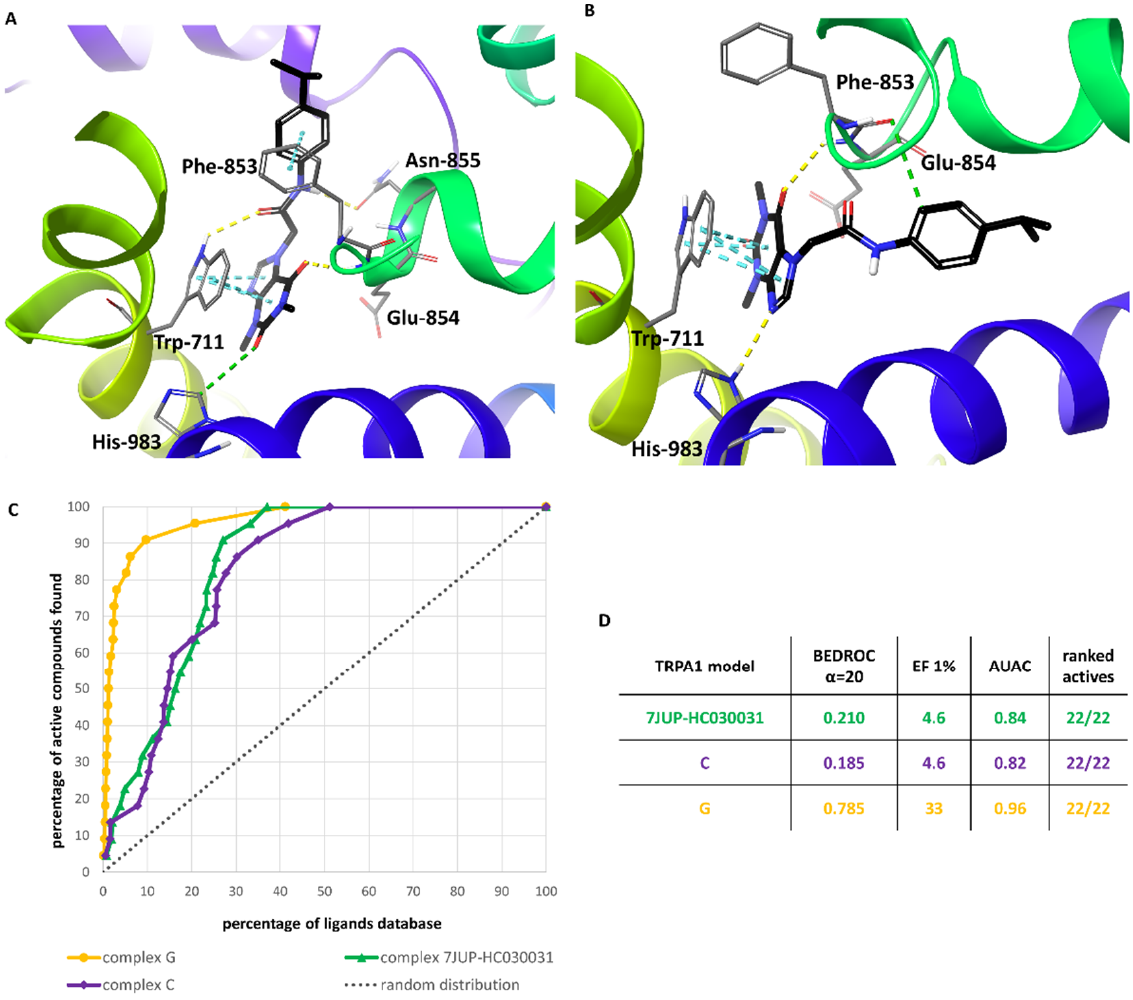
Figure 9. Binding modes of HC-030031 in complex G after relaxation protocol before MD simulation ( A ) and HC-030031 in the 7JUP-based model of the TRPA1 ion channel ( B ) The interactions are pre- sented as follows: yellow—hydrogen bonds, green—aromatic hydrogen bonds, cyan— π - π stacking. The results of retrospective virtual screening ( C )—enrichment plot for 7JUP-based model (green), model C (purple), and model G (orange) compared to the random distribution (dotted line); ( D )—VS benchmark property summary).